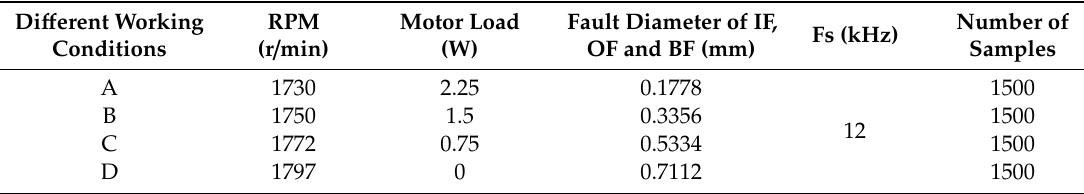
Table 1. Vibration signal parameter table for experimental data.